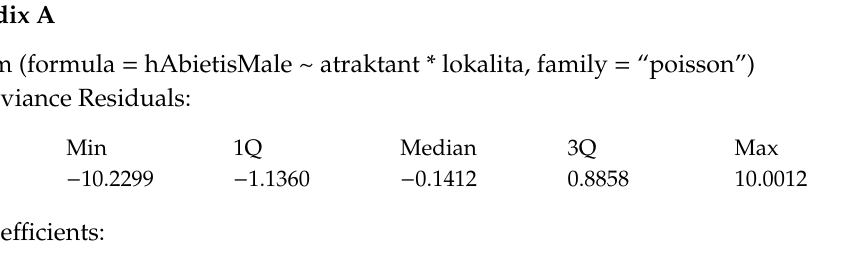
Table A1. Full GLM model of tested factors, locality and attractant, and their interactions.